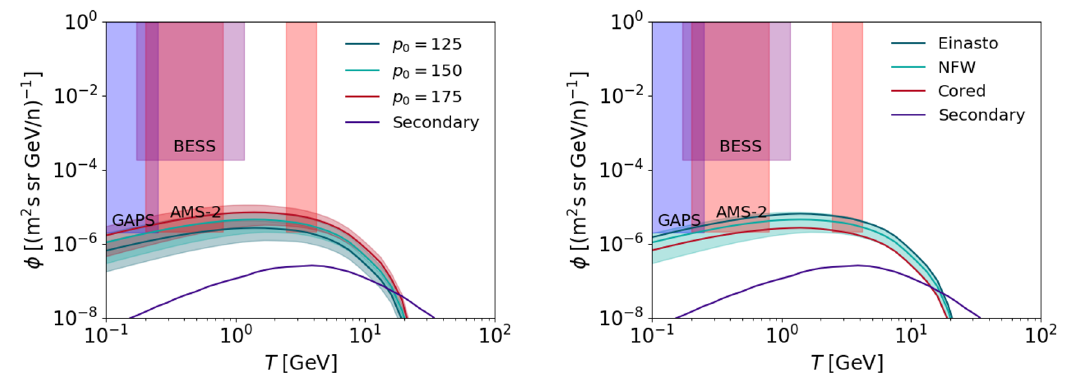
Figure 7. The sensitivity of expected antideuteron (cid:13)ux ( m (cid:31) = 50 GeV ; m A 0 = 30 GeV) to varia- tions in coalescence momenta (left) and halo pro(cid:12)les (right) used during injection and propagation steps.